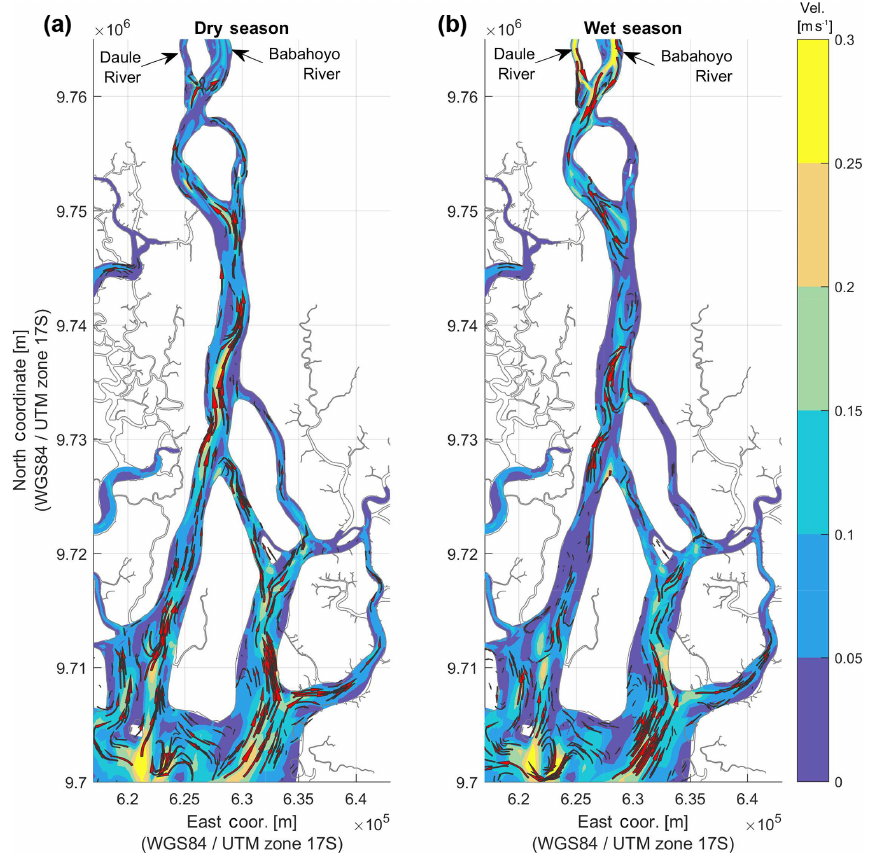
Figure 7. Tide-averaged residual current during the dry (a) and wet (b) seasons along the Guayas River.